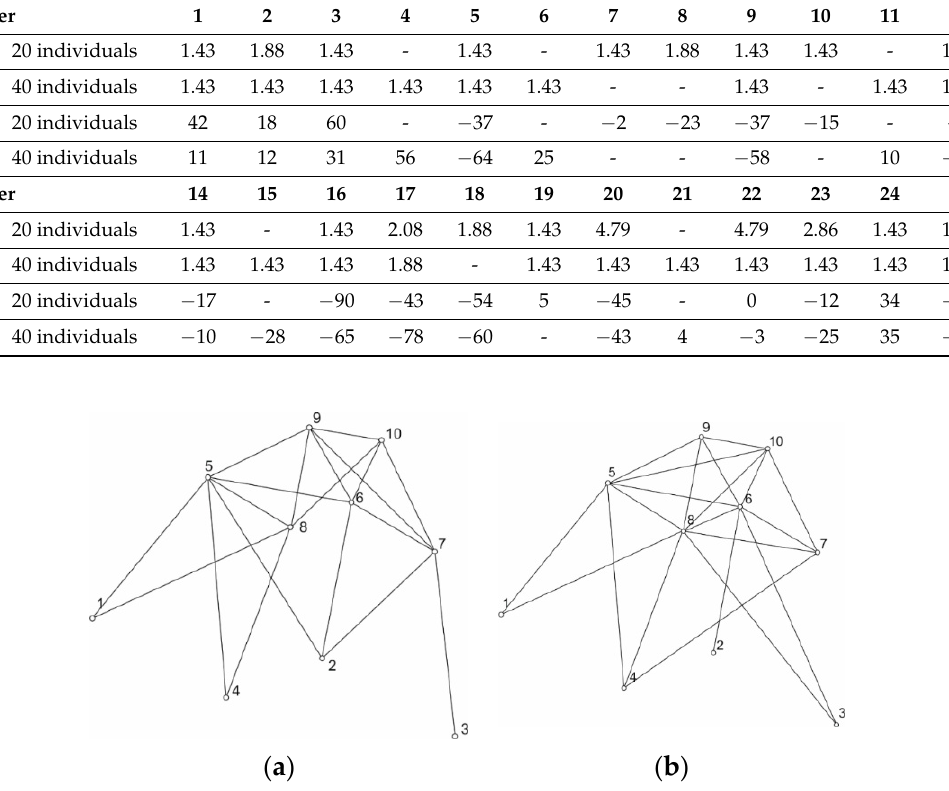
Figure 4. Optimized truss structure ( a ) for 20 individuals, ( b ) for 40 individuals. Example